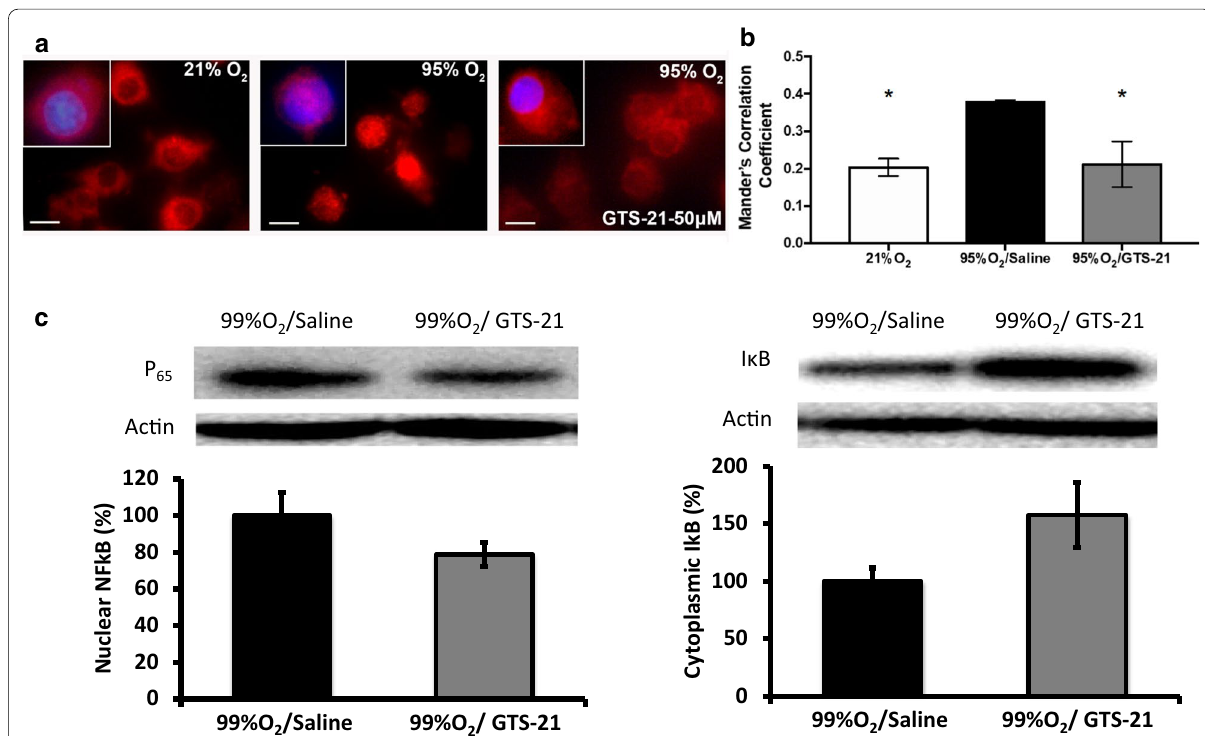
Fig. 5 GTS-21 inhibits hyperoxia-induced NF-κB activation. a RAW 264.7 cells were exposed either to 95% O 2 alone or 95% O 2 in the presence of GTS-21 (50 µM) or remained at 21% O 2 for 24 h. Following oxygen exposure, cells were washed with PBS, fixed, permeabilized and stained to localize the NF-κB p65 subunit (Red). Multiple pictures were taken using immunofluorescence microscope to visualize the localization of p65 subunit of NF-κB. Counterstaining with DAPI was used to visualize nuclei (Blue). b Immunofluorescent micrographs were quantified to determine the amount of p65 translocation into the nucleus by determining their Mander’s correlation coefficient. The immunofluorescence images shown are representative of two independent experiments. c C57BL/6 mice were exposed to 99% O 2 for 48 h and then inoculated with PA (0.1 10 8 ≥ × CFUs/mouse), and returned to 21% O 2 after inoculation. Mice were randomized to receive either GTS-21 (4 mg/kg) or saline, administrated by intraperitoneal injection, every 8 h starting at 32 h during hyperoxia. Lungs of these mice were used to prepare nuclear and cytoplasmic extracts. A representative image of Western blot immunoreactive bands of NF-κB p65 in the nuclear extract and IκB in the cytoplasmic extract of lungs of these mice. Bar graph showing the integrated density value of NF-κB p65 in the nuclear extract and IκB in the cytoplasmic extract of mice that received saline (black bar) and GTS-21 (4 mg/kg) (grey bar; n 5 for saline, and n 6 for GTS-21 treated mice). β actin expression was measured as a loading = =